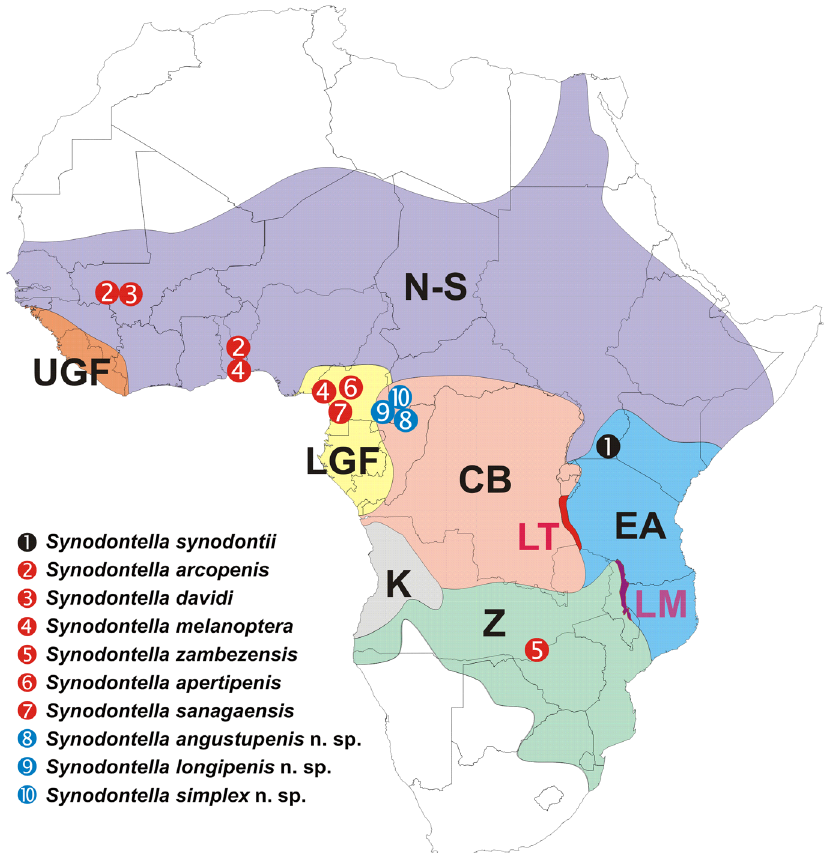
Figure 6. Map showing the major ichthyological provinces of Africa [Nilo-Sudan (N-S), Upper Guinea Forest (UGF), Lower Guinea Forest (LGF), Congo Basin (CB), Quanza (K), Zambezi (Z), East Africa (EA), Lake Tangayika (LT) and Lake Malawi (LM)], with the type localities of described Synodontella spp. (in blue: species with horseshoe-shaped dorsal bars) (modi fi ed after